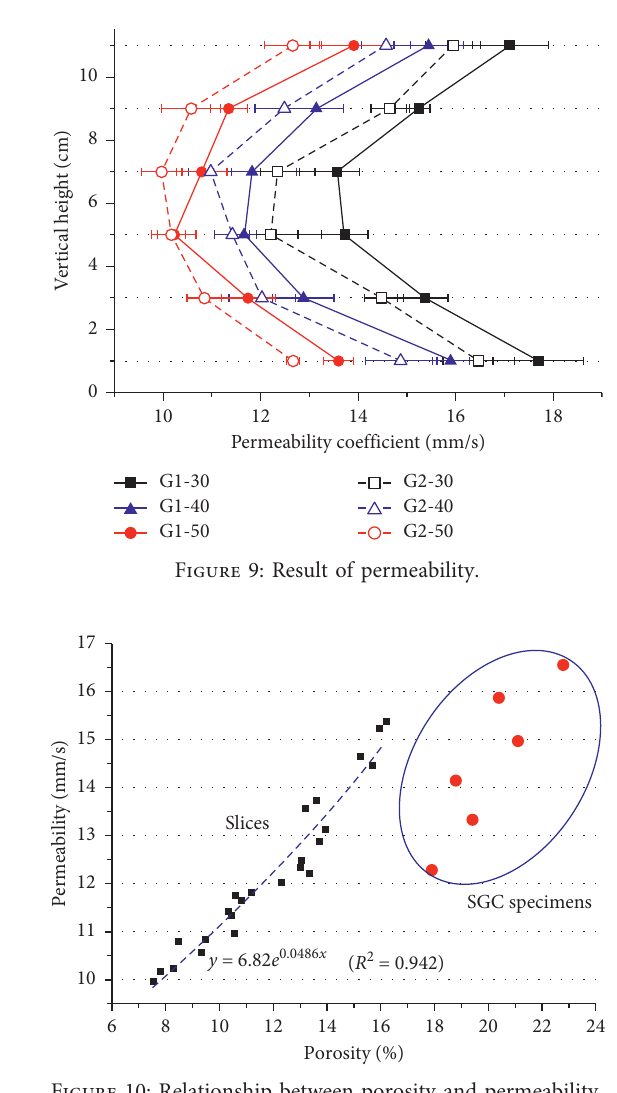
Figure 10: Relationship between porosity and permeability.